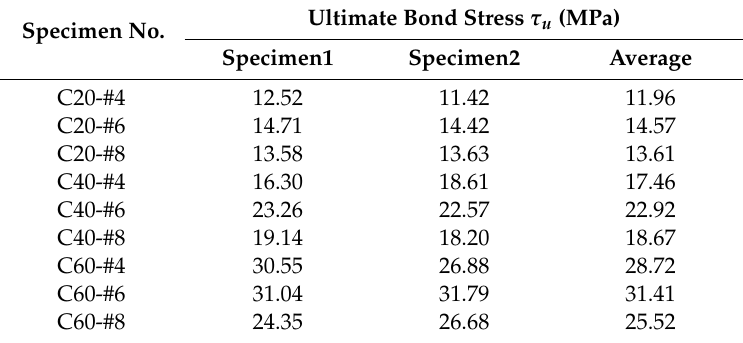
Table 6. Test result of ultimate bond